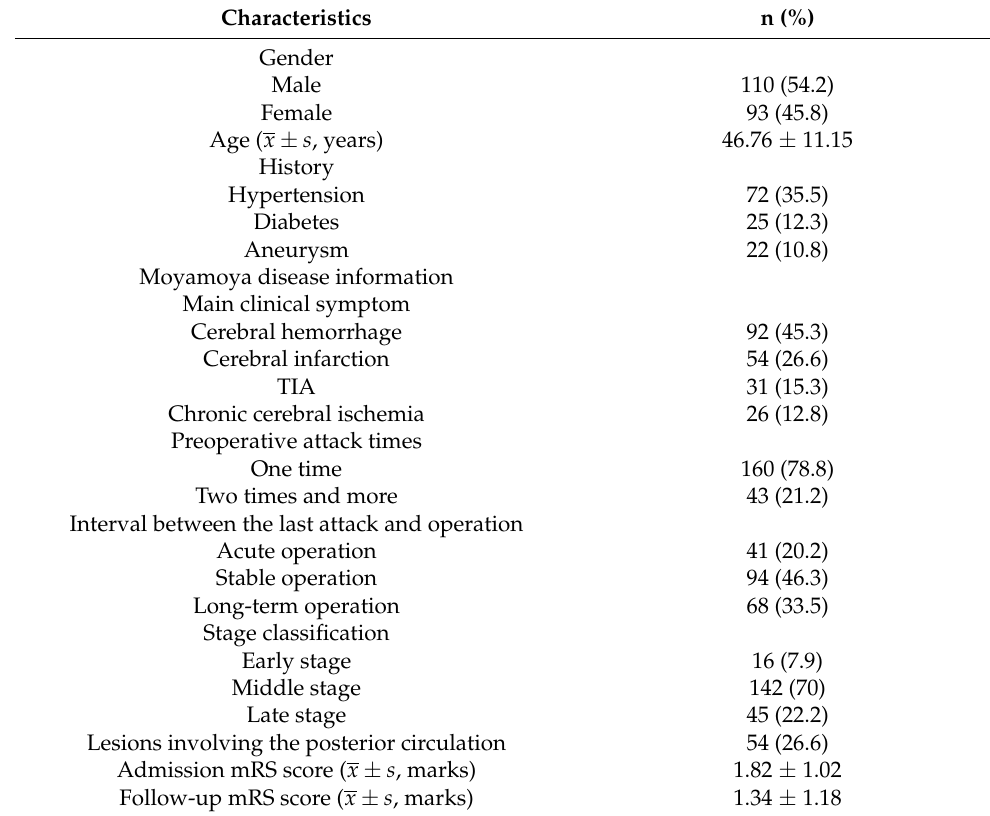
Table 1. Baseline Characteristics of 203 cases of revascularization of